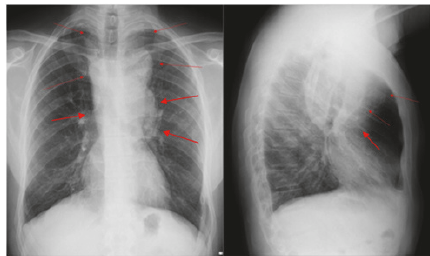
Figure 1: Chest X-ray in PA and Profile shows enlargement of the mediastinum (red arrows).